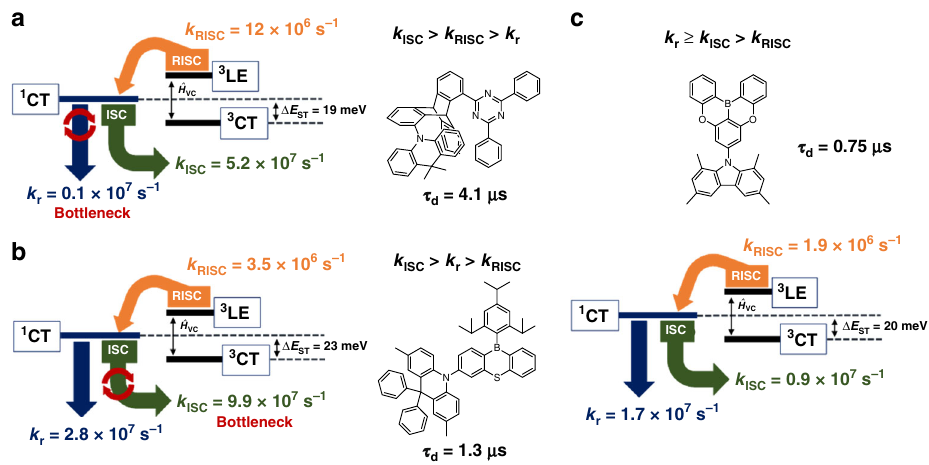
Fig. 7 Schematic illustration of plausible TADF mechanism. a TpAT-tFFO, b MPAc-BS, and c TMCz-BO . k r , k ISC , k RISC , CT, LE, and Δ E ST represent the rate constants of fl uorescence radiative decay, intersystem crossing (ISC), reverse ISC (RISC), charge-transfer and localized excited states, and energy gap between lowest singlet and triplet excited